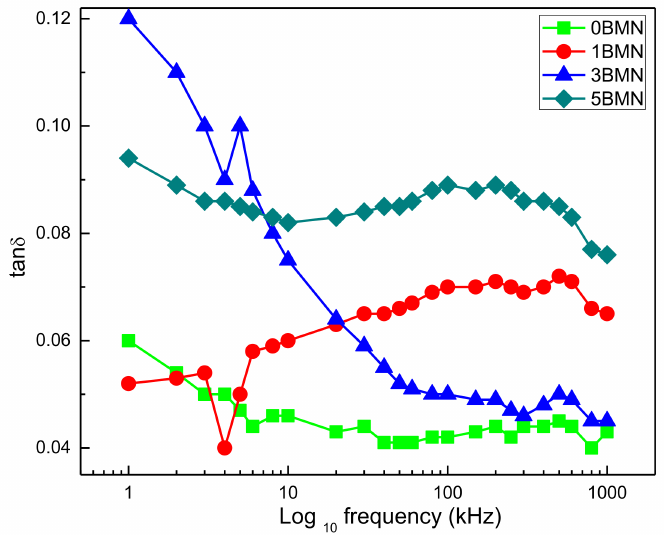
Figure 6. Frequency dependence of dielectric loss (tan δ